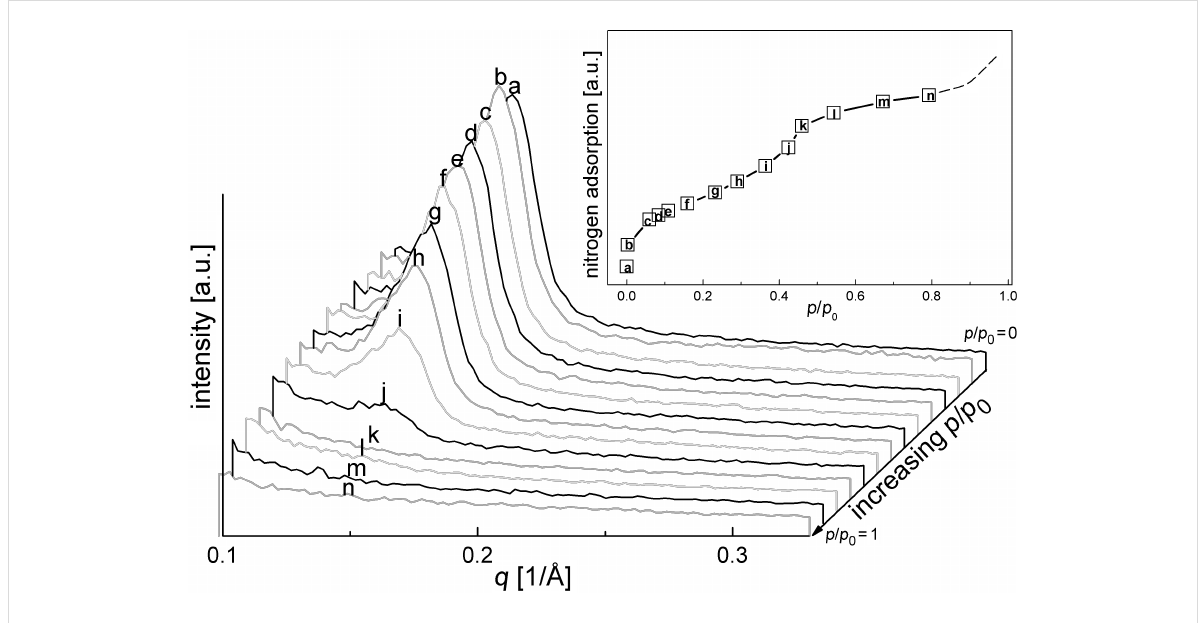
Figure 2: Neutron diffraction patterns of benzene-PMO at small q values and different amounts of adsorbed nitrogen.